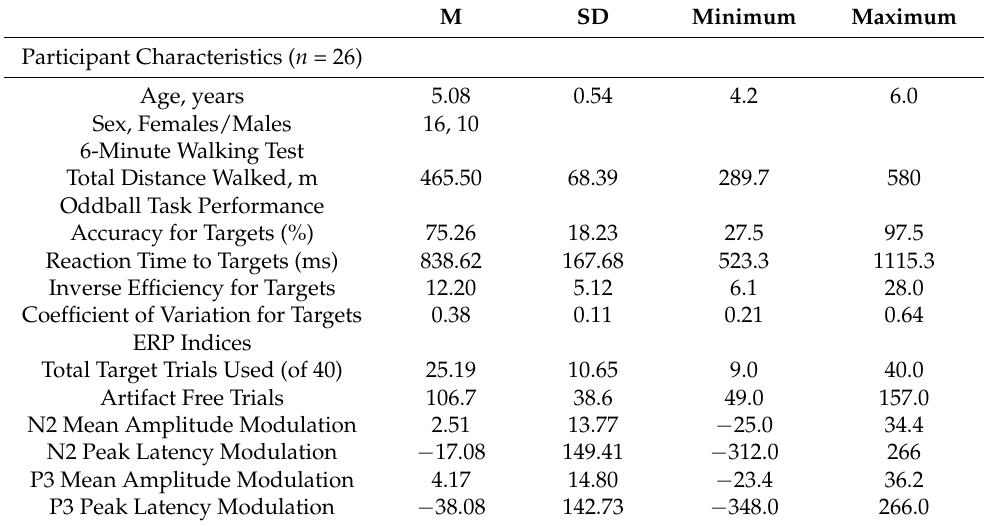
Table 3. Participant characteristics and performance indices for the subsample of children who completed the auditory oddball task.